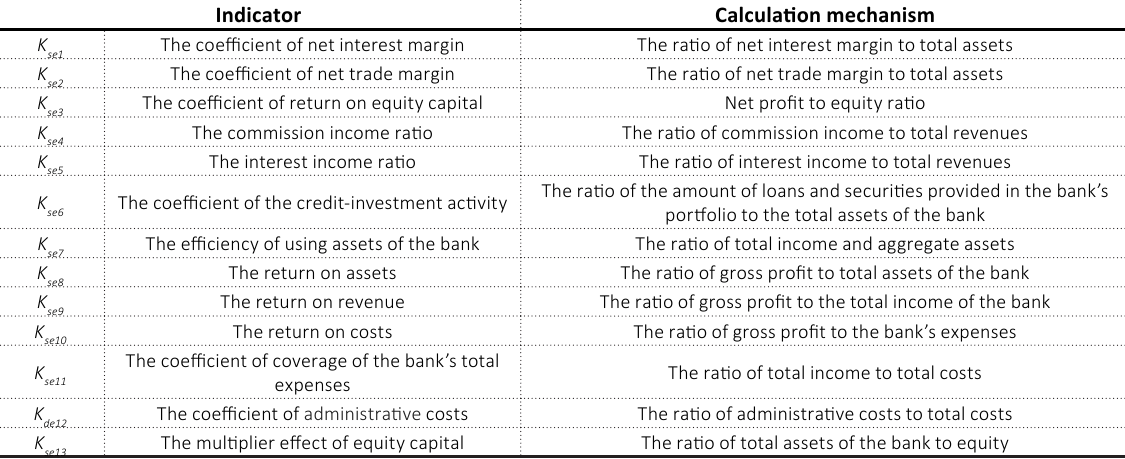
Table 1. Indicators of effectiveness in the bank activities assessment